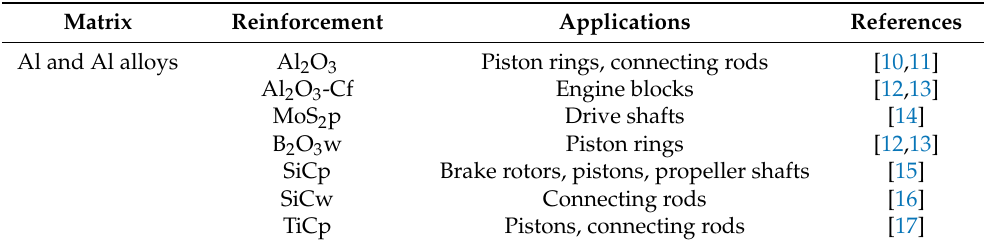
Table 1. List of automotive application of Al-based MMCs with different reinforcements.